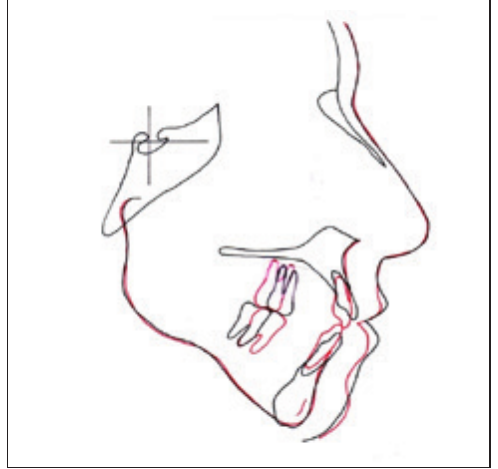
Figure 11. Local superimpositions done according to Bjork’s structural superimposition technique.